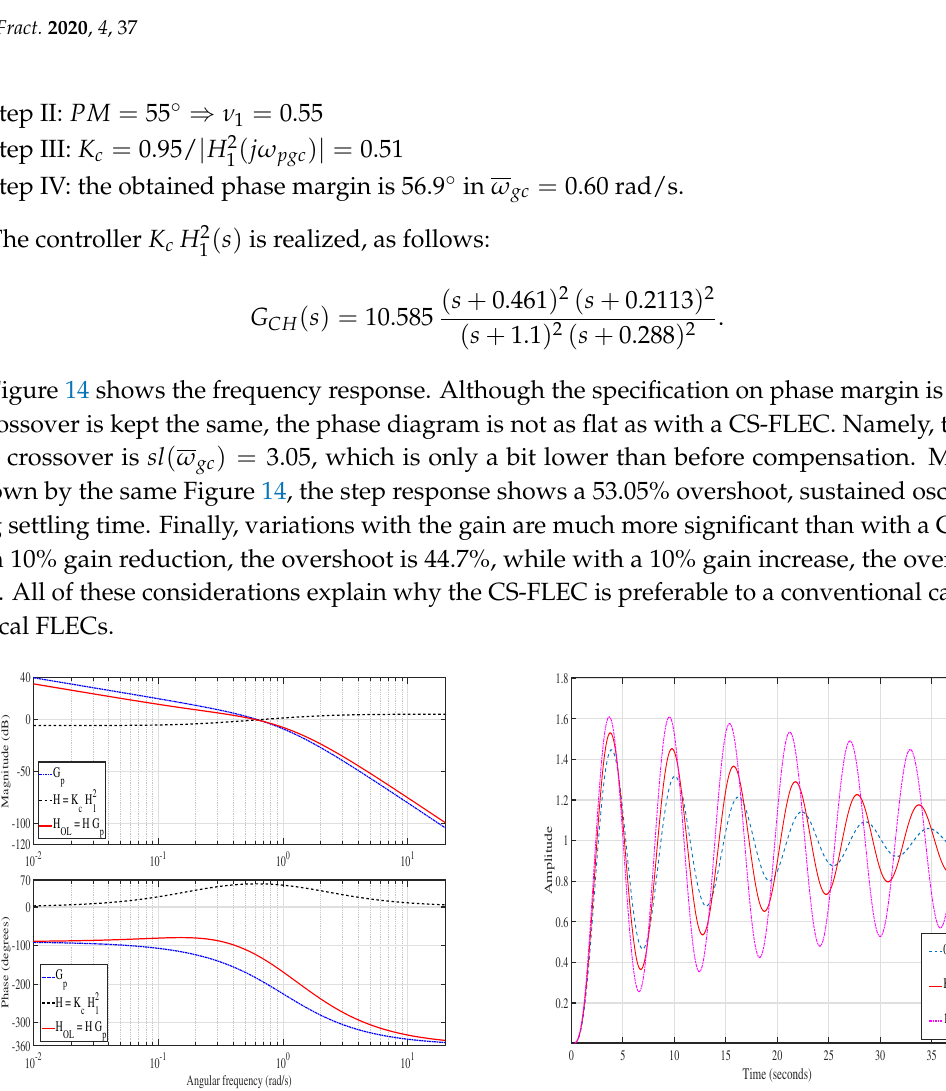
Figure 14. Left: frequency response by the first plant G p 1 (dash-dotted lines), the compensator H with two identical FLECs (dashed lines), and the compensated system H OL (solid lines). Right: unit step response for different values of K c